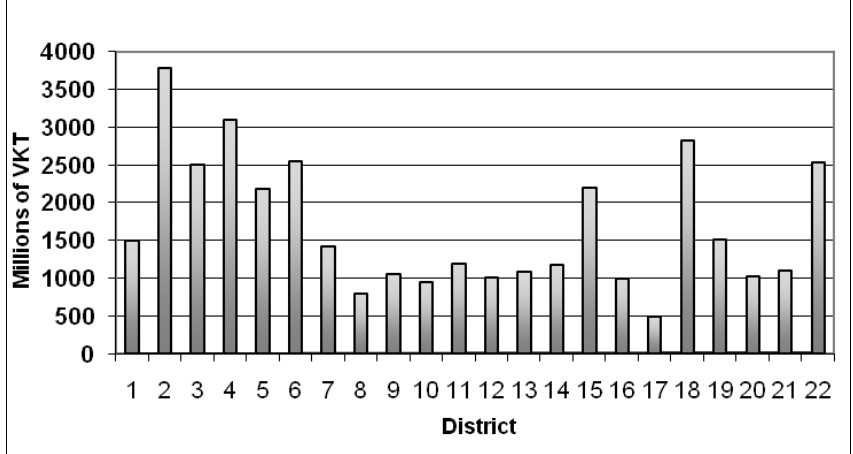
Figure 2. VKT per districts for the